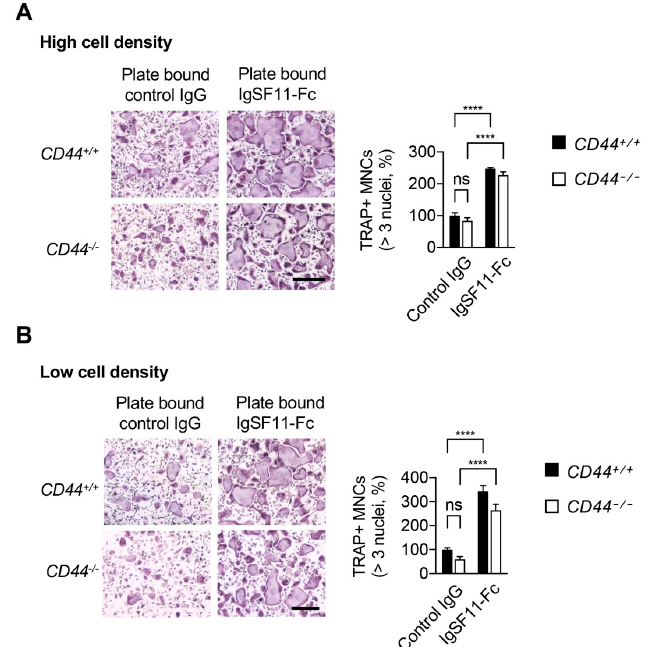
Figure 3. Stimulation of IgSF11 exerts a pro-osteoclastogenic effect in a CD44-independent manner. CD44 +/+ and CD44 − / − BMMs were seeded on plate-bound control IgG or IgSF11-Fc at ( A ) high cell density, or ( B ) low cell density, and cultured with M-CSF + RANKL for three days to induce osteoclast differentiation. On day three, cells were fixed and stained with TRAP (left). TRAP + multinucleated cells (three nuclei or more per cell) were counted and the frequency of TRAP + multinucleated cells is shown (right). Scale bars represent 100 μ m. Data are shown as the mean ± S.D. **** p < 0.0001, ns; not significant.